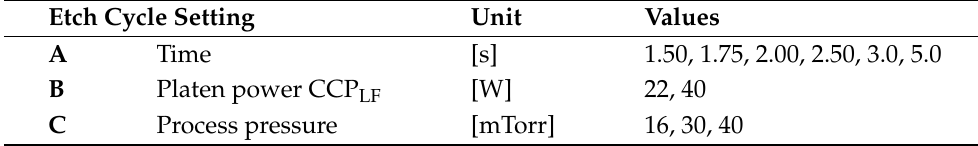
Table 4. Optimisation settings for the etch cycle in the Bosch-based HAR trench